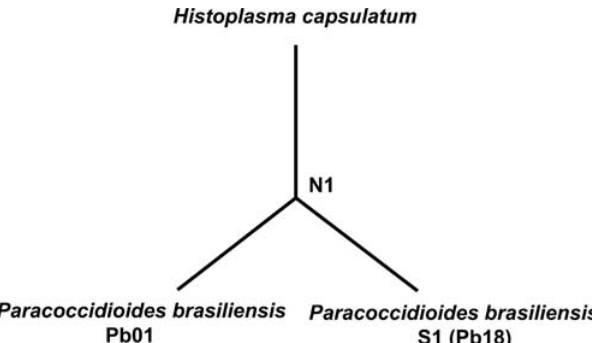
Figure 1. The phylogeny of H.capsulatum , P.brasiliensis Pb18, and P.brasiliensis Pb01 .N1 is the common ancestor of the three branches of the tree.